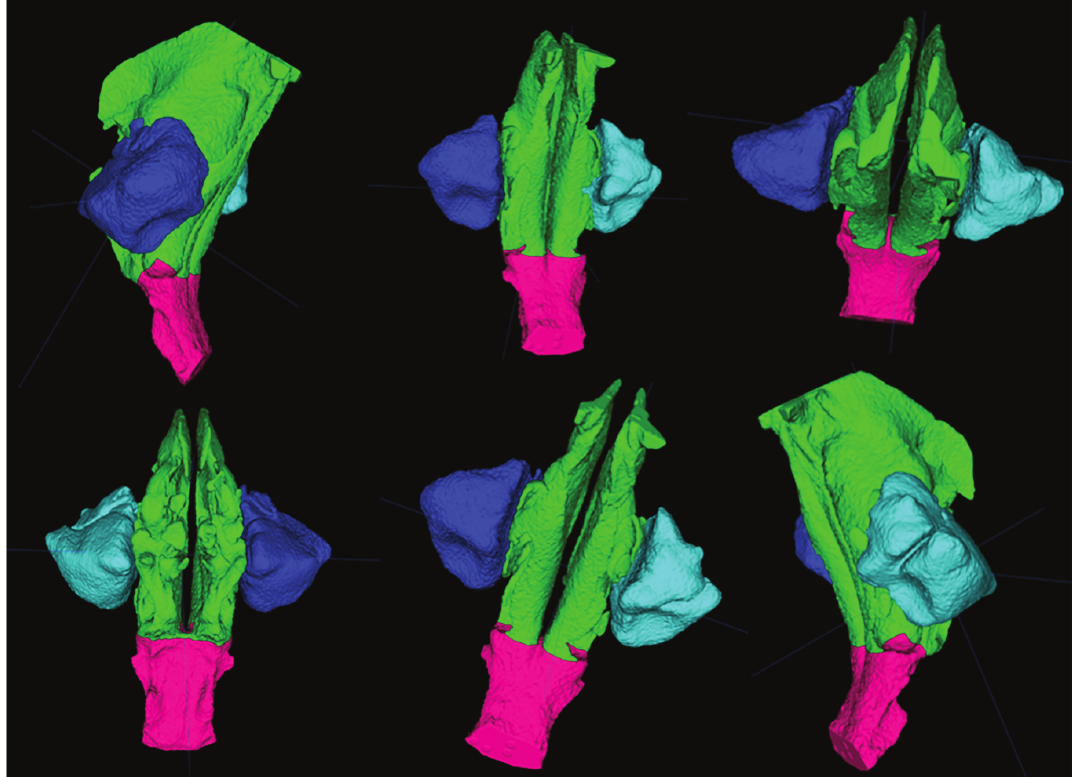
Figure 2. Multiple view of studied reconstructed volumes segmented into the different portions analyzed in this study: Nasal cavity, maxillary sinuses, and rhynopharynx.